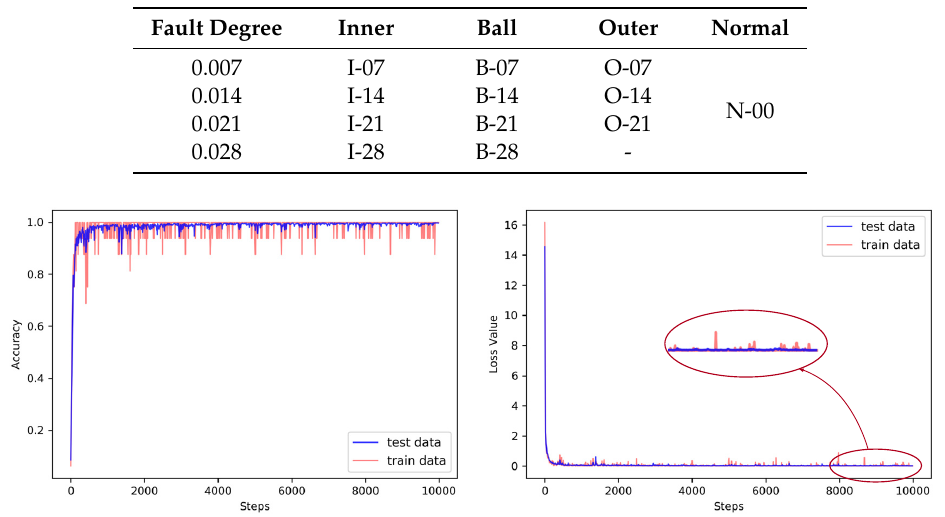
Table 2. The labels of data with different fault types and different degrees.